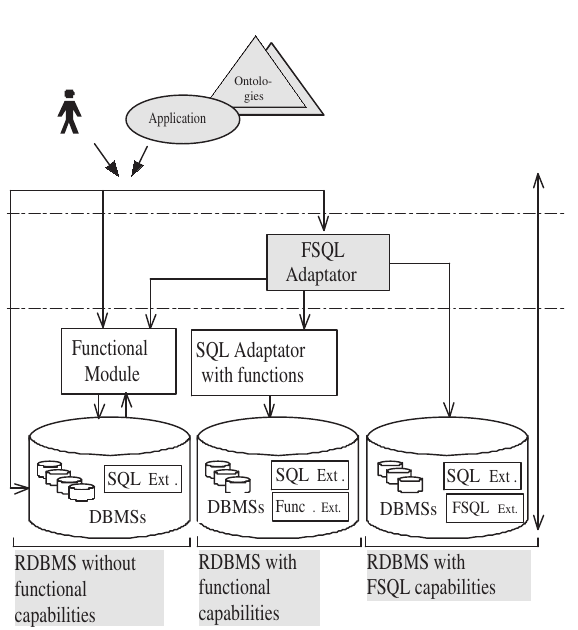
Fig. 6. Database communication